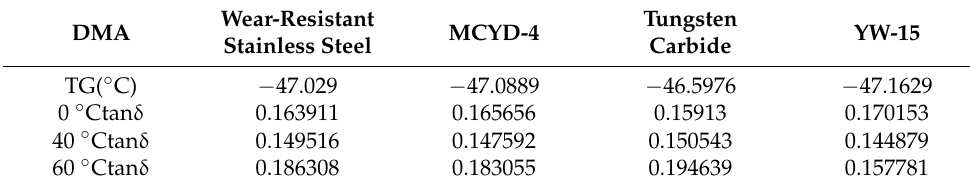
Table 7. TG and Tan δ of NR/BR composites after friction with different metals.